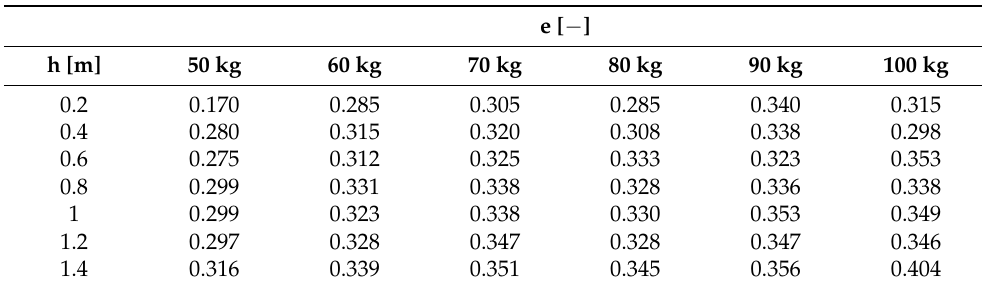
Table 1. Coefficient of restitution, e, of the rebounding process for the hammer with the spherical impactor in individual measurements.